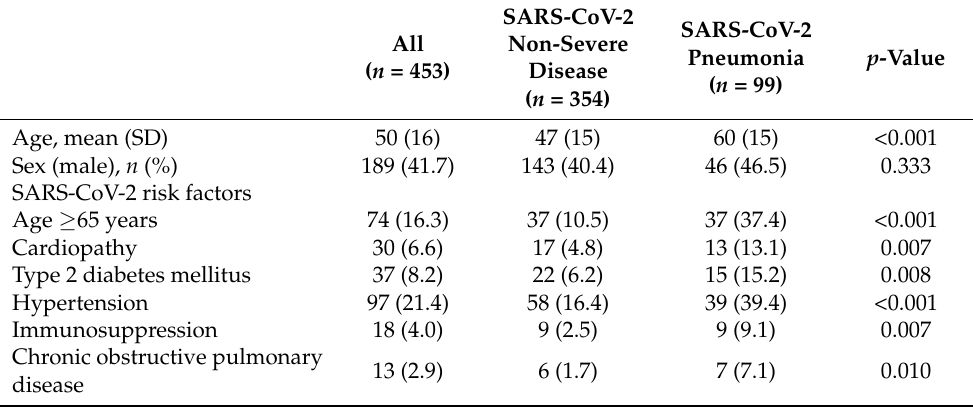
Figure 1. Flow chart of the study. Table 1. Characteristics of patients with SARS-CoV-2 infection included in the cohort.